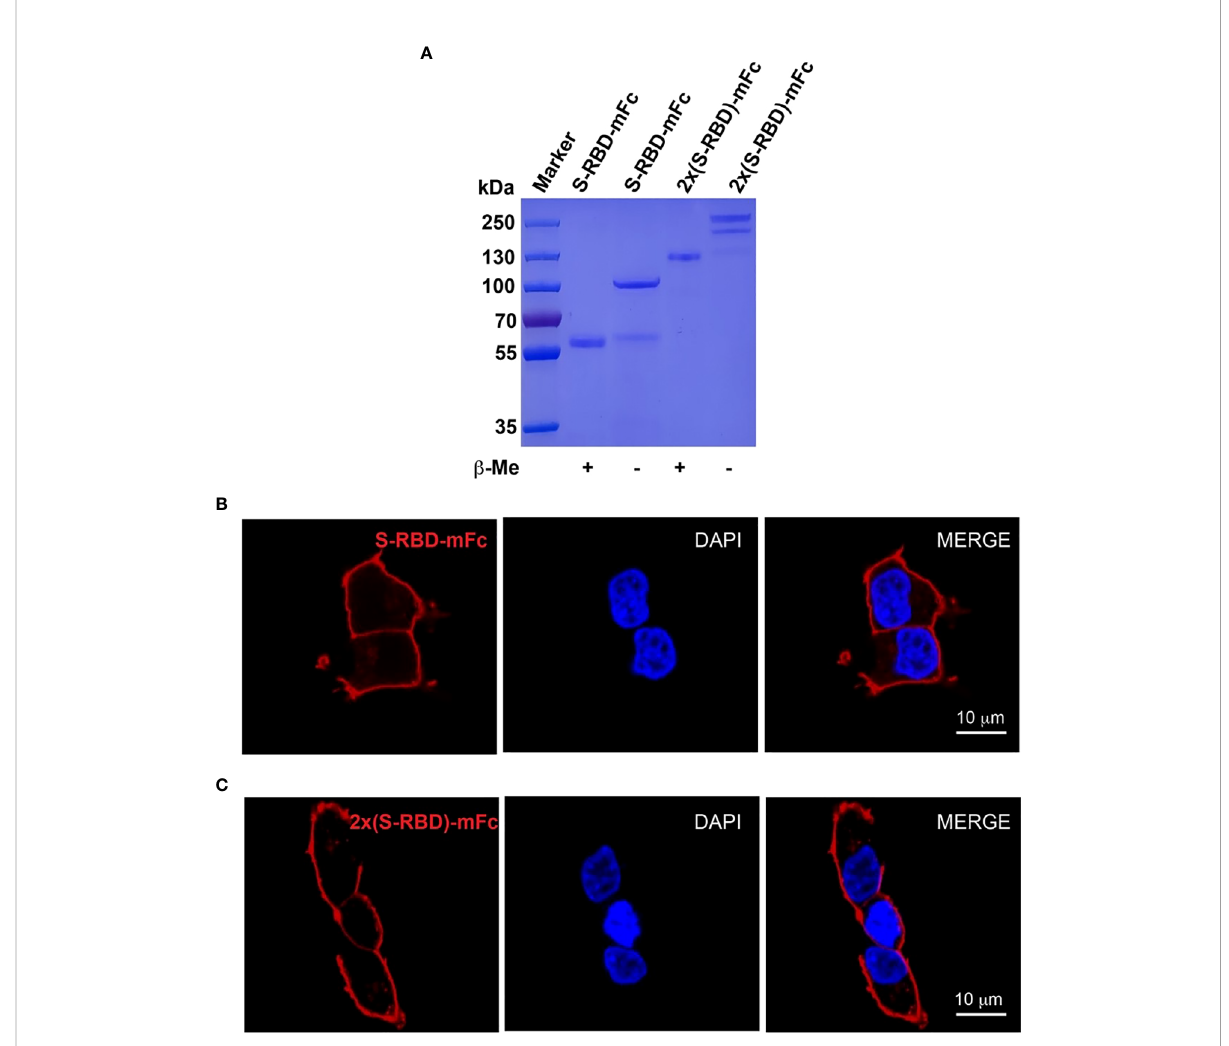
FIGURE 2 Expression and characterization of S RBD -mFc and 2xS RBD -mFc. (A) SDS-PAGE analysis of puri fi ed S RBD -mFc and 2xS RBD -mFc fusion proteins in reduced and non-reduced conditions, respectively. (B, C) Confocal microscope images show the S RBD -mFc and 2xS RBD -mFc binding to human ACE2 expressed on the HEK293T-hACE2 cell surface (DNA DAPI staining in blue, S RBD -mFc or 2xS RBD -mFc staining in red). Scale bars, 10